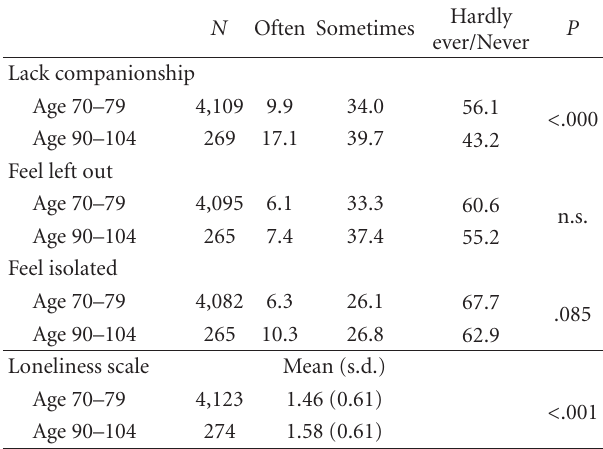
Table 3: Di ff erences in loneliness between the old (age 70–79) and the oldest-old (age 90–104), HRS